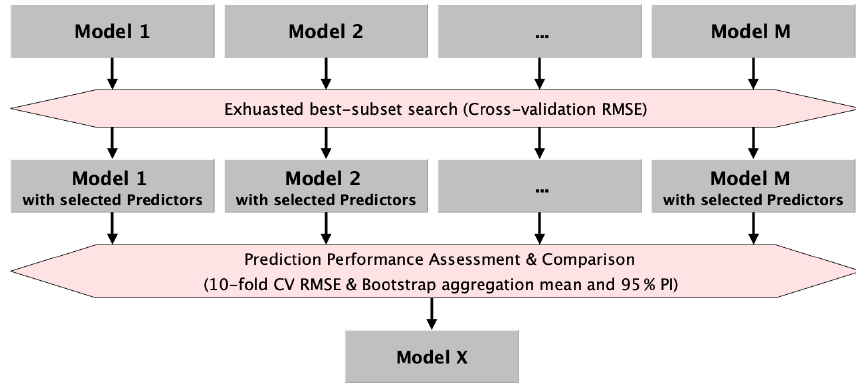
Figure 2. A flowchart of building up regression